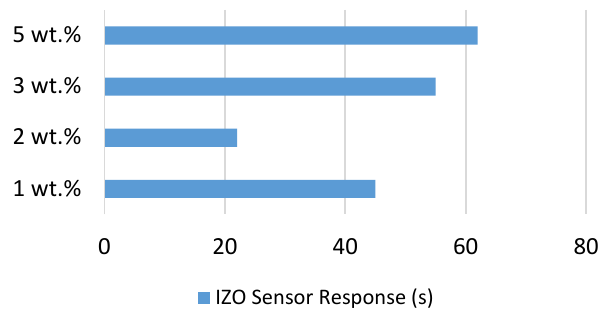
Figure 18. Response time for different in doping concentrations. IZO, Indium doped ZnO.